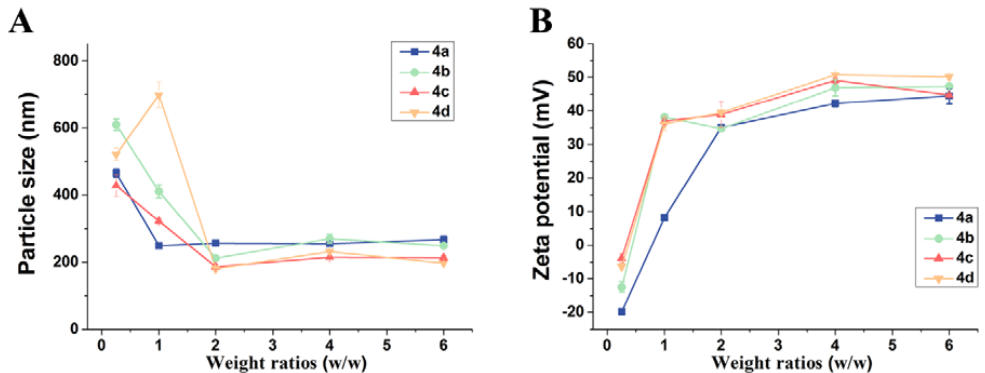
Figure 2. Particle size ( A ) and zeta-potential ( B ) of polymer/DNA polyplexes obtained at various w / w ratios by DLS. Data are represented by mean ± standard deviation (S.D.) ( n = 3).